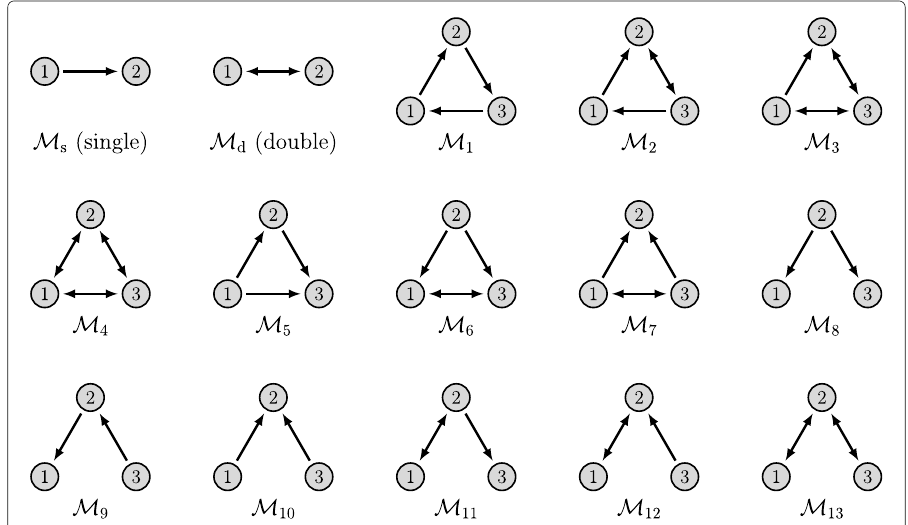
Fig. 1 All simple directed motifs on at most three